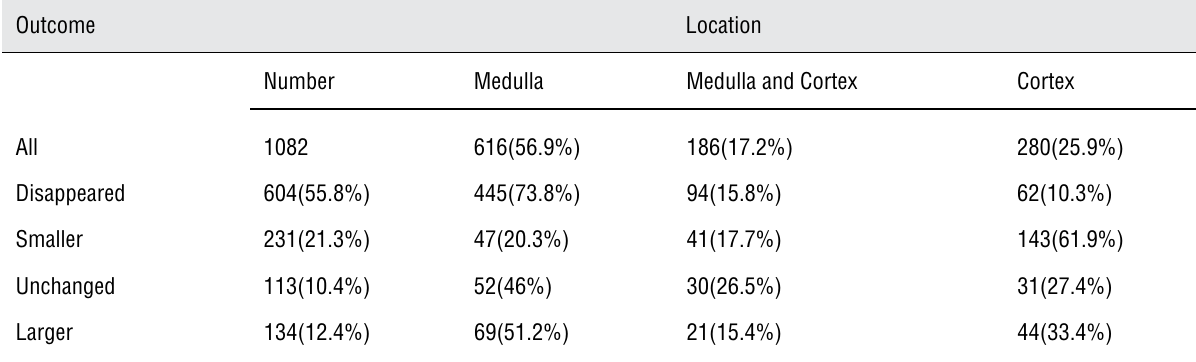
Table 1 - Location and Outcome of 1082 small Renal Masses on Follow-up CT (after 4-26